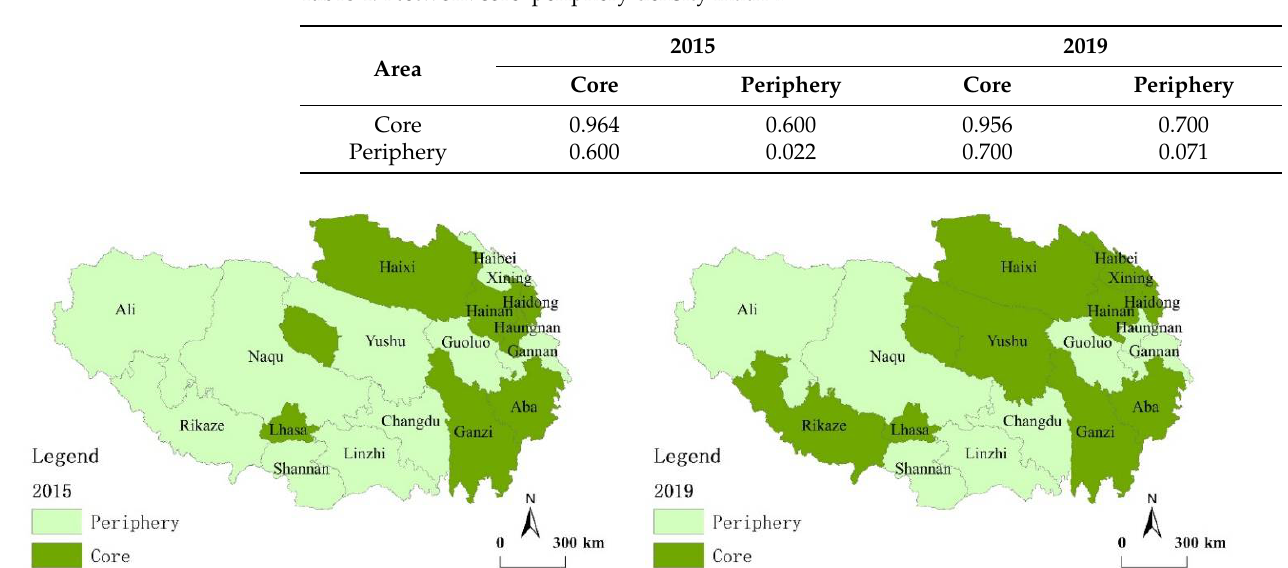
Figure 6. Core–periphery model.